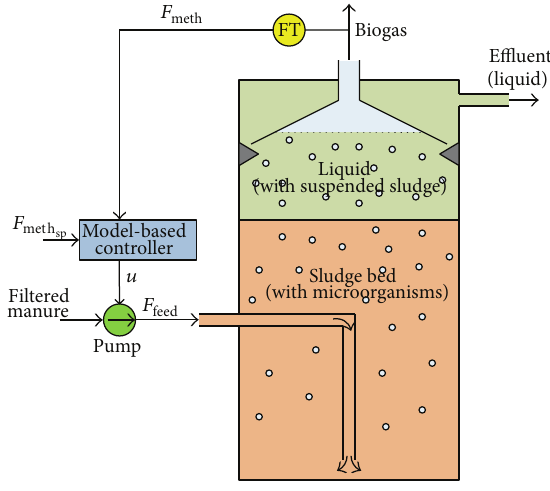
Figure 1: Control system of the AD